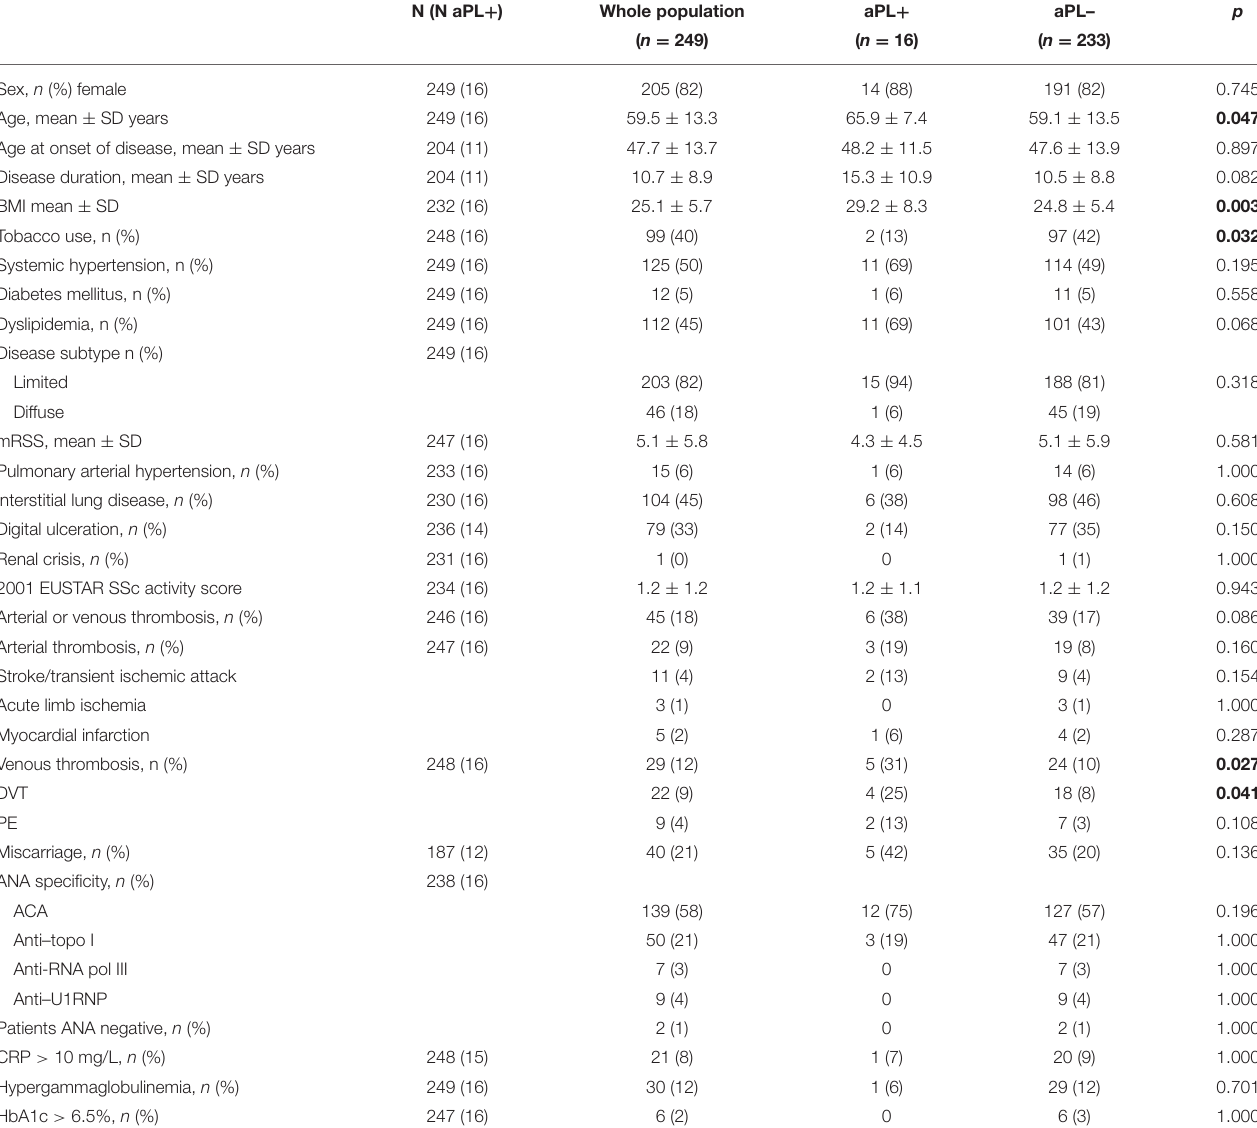
TABLE 1 | Characteristics of the population included in the study, and comparison between aPL positive or negative patients (single testing). N (N aPL + ) Whole population aPL +